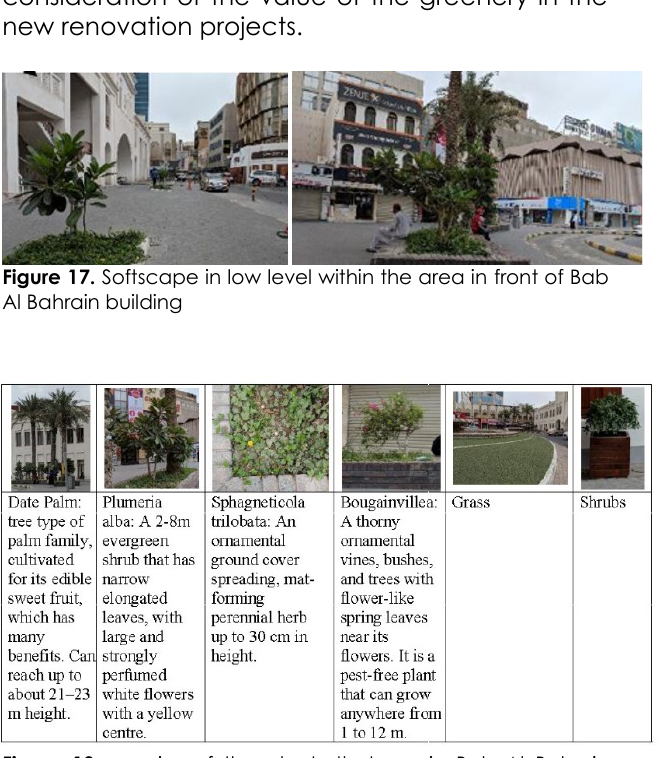
Softscape scattered (figure 17:19) in low number